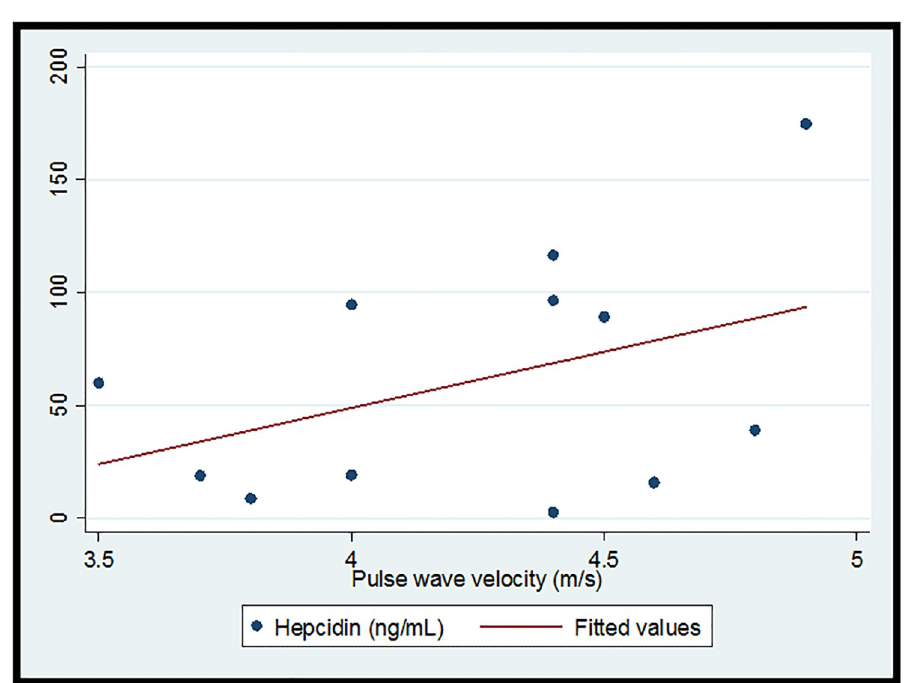
Fig 2. Correlation and linear prediction plot for hepcidin and pulse wave velocity in children with SLE, outlier value excluded. r = 0.41, p = 0.18. https://doi.org/10.1371/journal.pone.0214248.g002 American females. Although significance was limited by small sample size, the point esti- mates for both serum hepcidin and measured PWV were higher in the subjects with LN. A post-hoc power calculation demonstrated 27% power to detect the observed differences in hepcidin and 45% power to detect the observed differences in PWV, confirming that small Table 1. Demographic and clinical characteristics by nephritis status in 16 children and adolescents with systemic lupus erythematosus. Median (IQR) or n